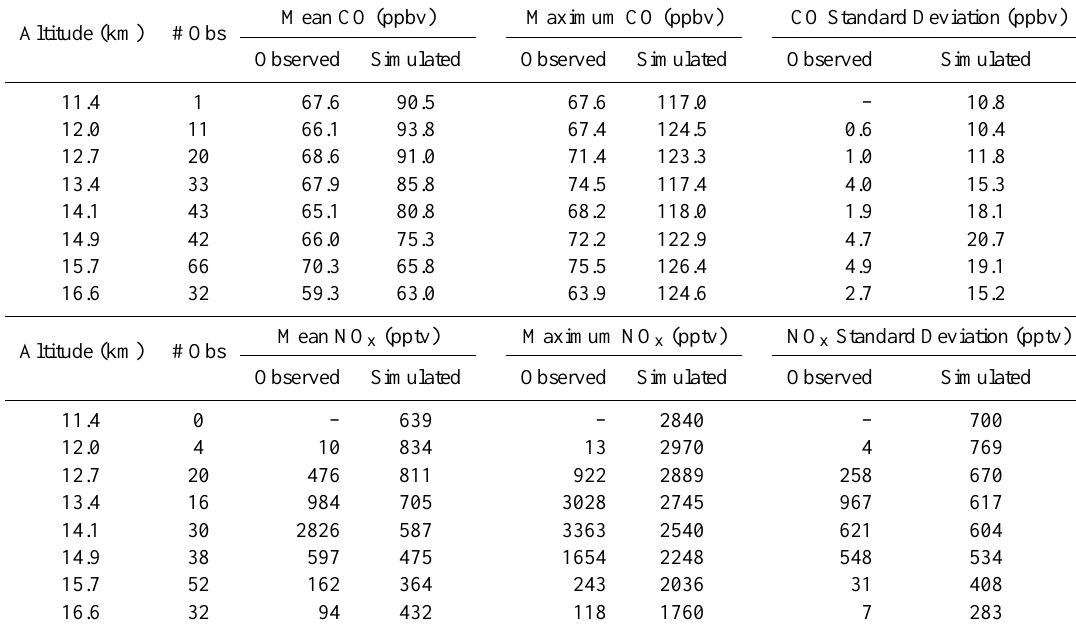
Table 5. Statistics for the Geophysica observed and simulated tracer mixing ratios for multiple layers centered at 11.4–16.6km. Simulated values are based on a lightning NO production scenario of 500molesflash − 1 . Altitude (km)